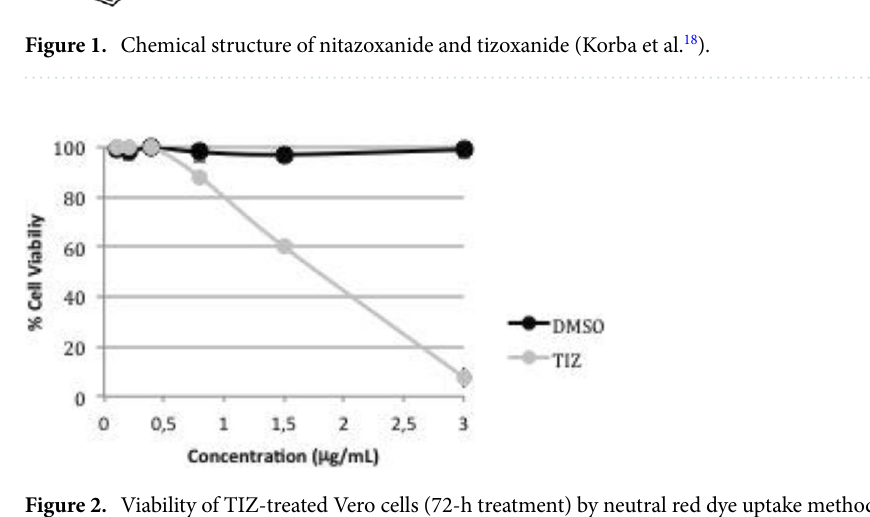
Figure 2. Viability of TIZ-treated Vero cells (72-h treatment) by neutral red dye uptake method. Data are presented as mean % cell viability of six replicates, compared to non-treated cell controls ± SD. The SD bars are obscured by the